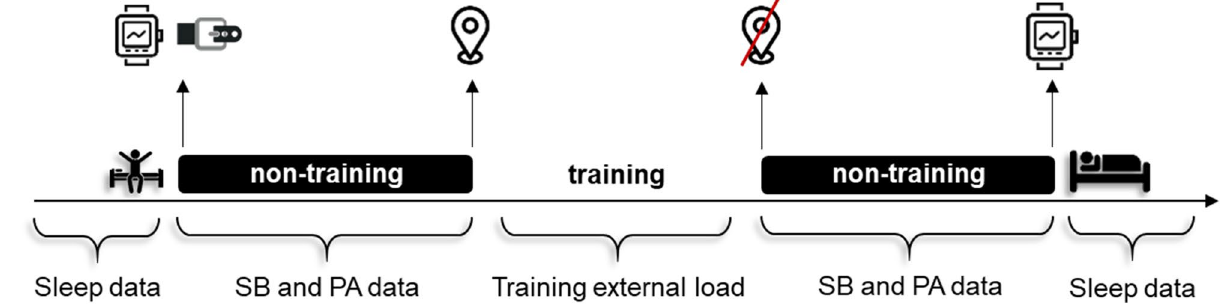
Figure 3. Representation of a data collection day. = wake up; = go to the bed at night; = wear GPS; = remove GPS; = accelerometer on the elastic belt; = accelerometer worn on the wrist. PA physical activity, SB sedentary